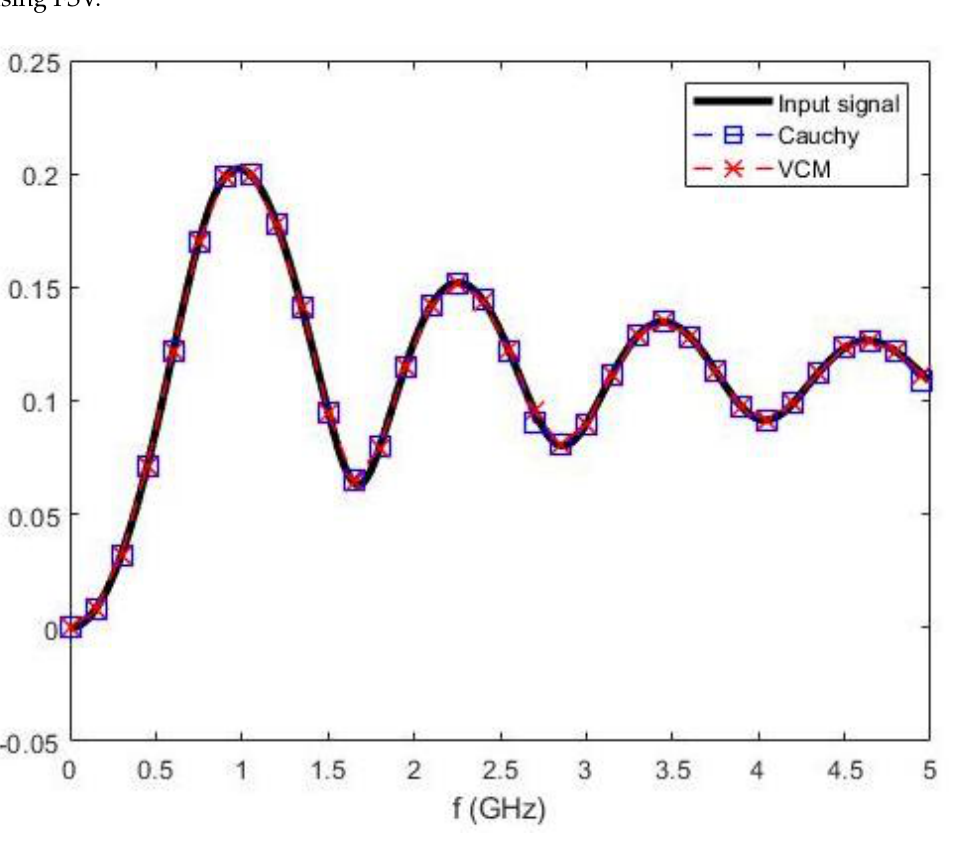
Figure 2. Metal sphere signal approximation using the Cauchy and VCM